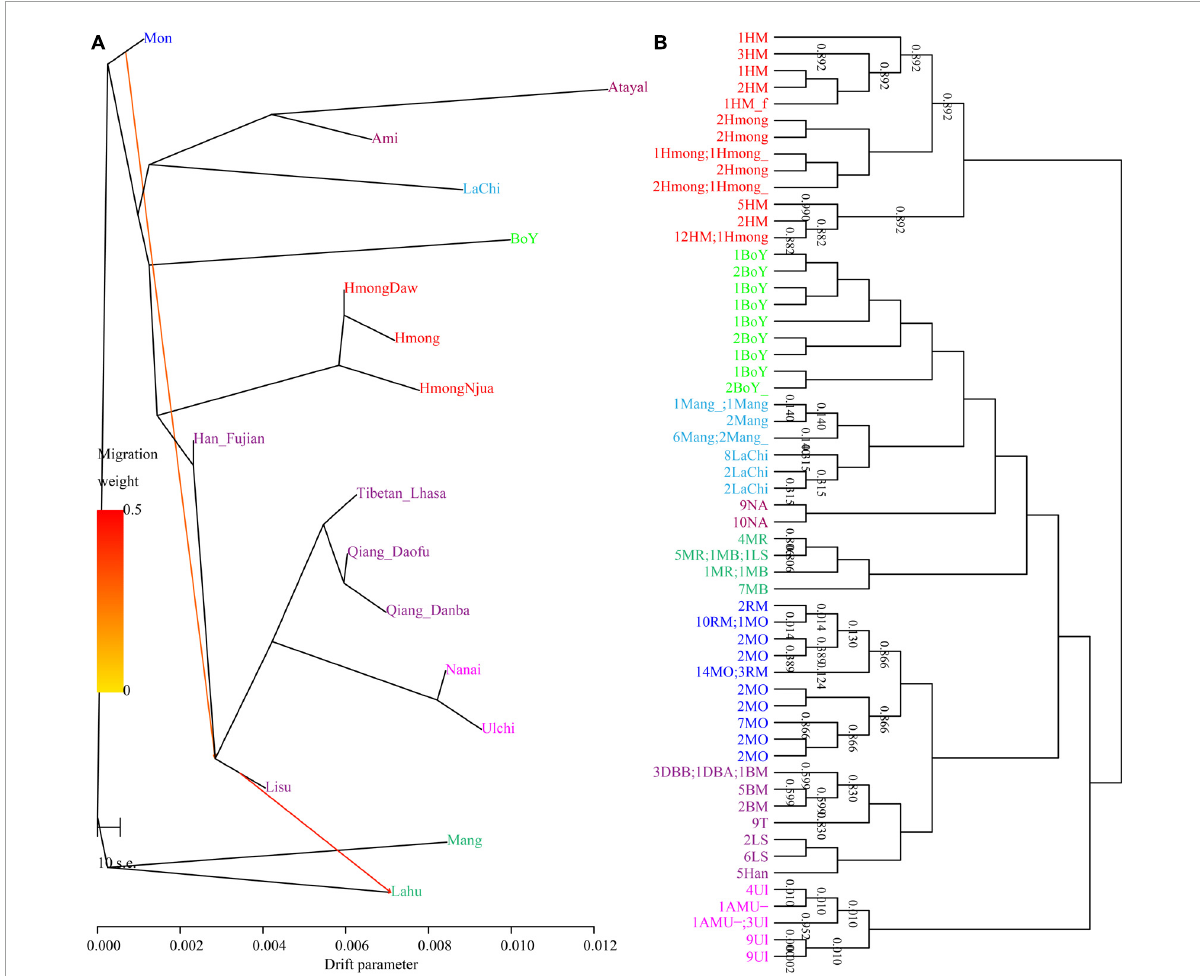
FIGURE9 Phylogenetic clustering patterns based on the sharing alleles and the reconstructed haplotypes. (A) TreeMix-based clustering patterns with two migration events. (B) Fine structure results showed a close relationship between Qiang and Tibetan people. The same color denotes the same populations. HM, Hmong; NA, Qiang; MR, Mang; LS, Lisu; MO, Mon; MB, Lahu; RM, Mon; DBB, Qiang_Danba; DBA, Qiang_Danba; BM, Qiang_Daofu; T, Tibetan; LS, Lisu; Ul, Ulchi; AMU,